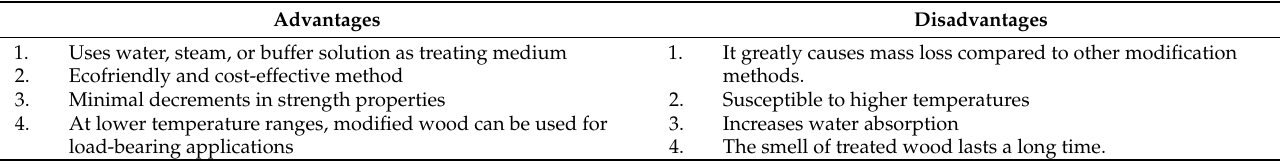
Table 2. Advantages and disadvantages of hydrothermal wood